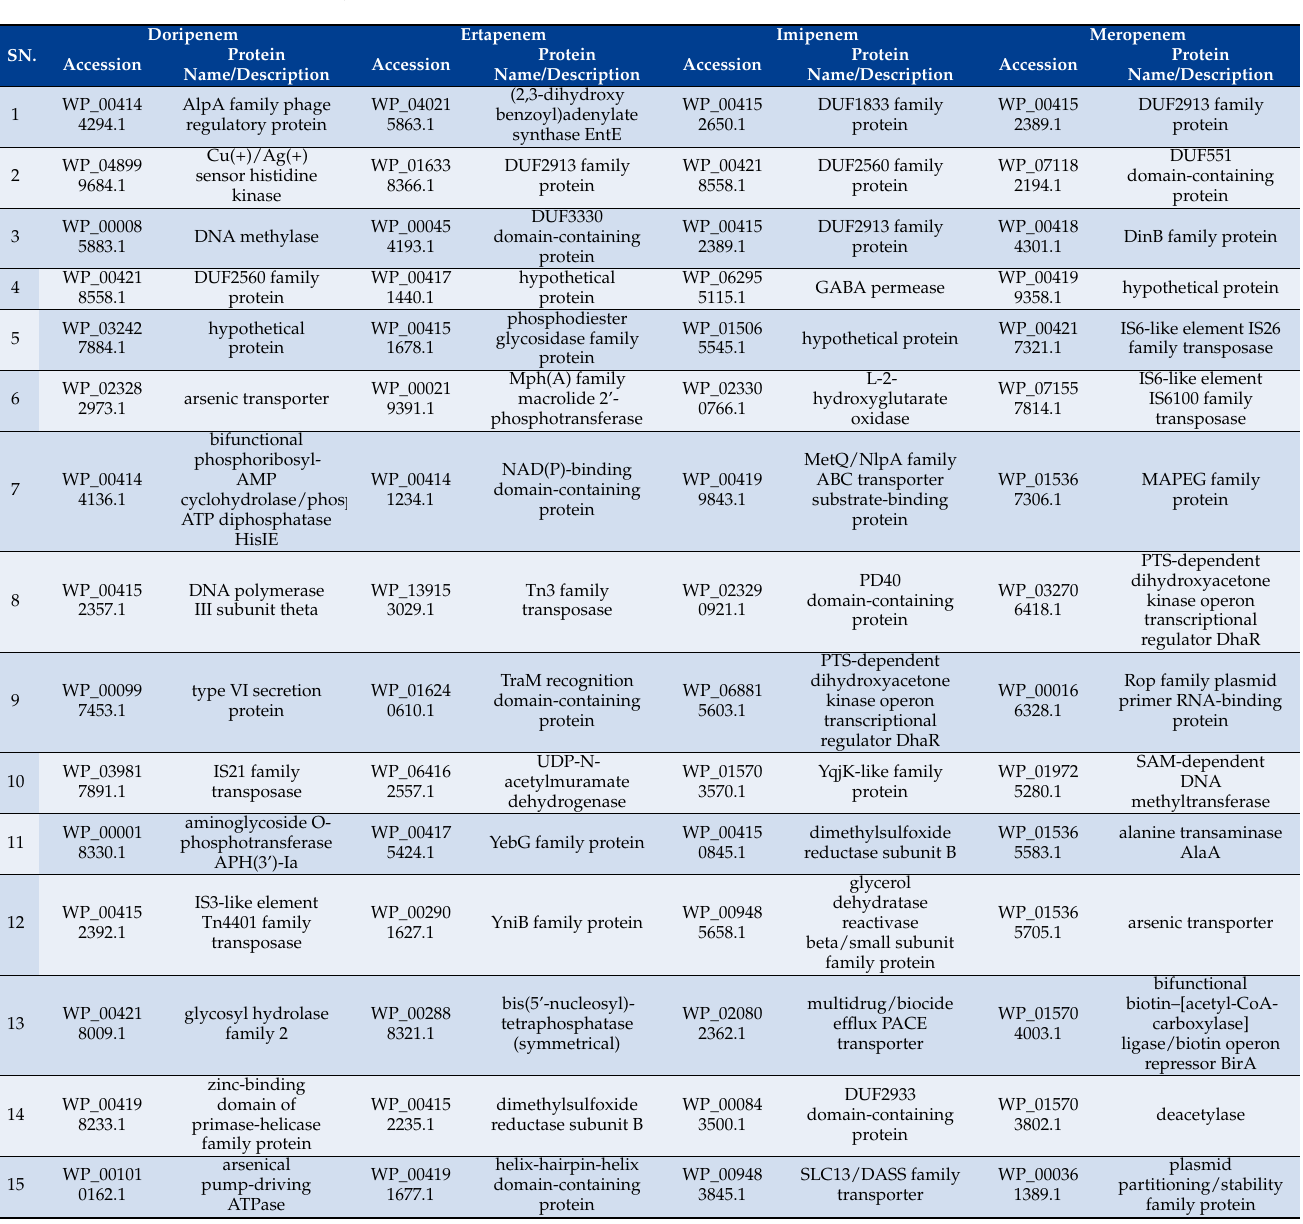
Table 2. Top ranked putative novel AMR genes in K. pneumoniae , not yet implicated as carbapenem resistant genes, following the verification of their presence in the resistant strains for each antibiotic (Doripenem, Ertapenem, Imipenem, and Meropenem). These novel AMR genes appeared among top ranked genes of importance by machine learning in each round of the 6-fold cross validation for K. pneumoniae